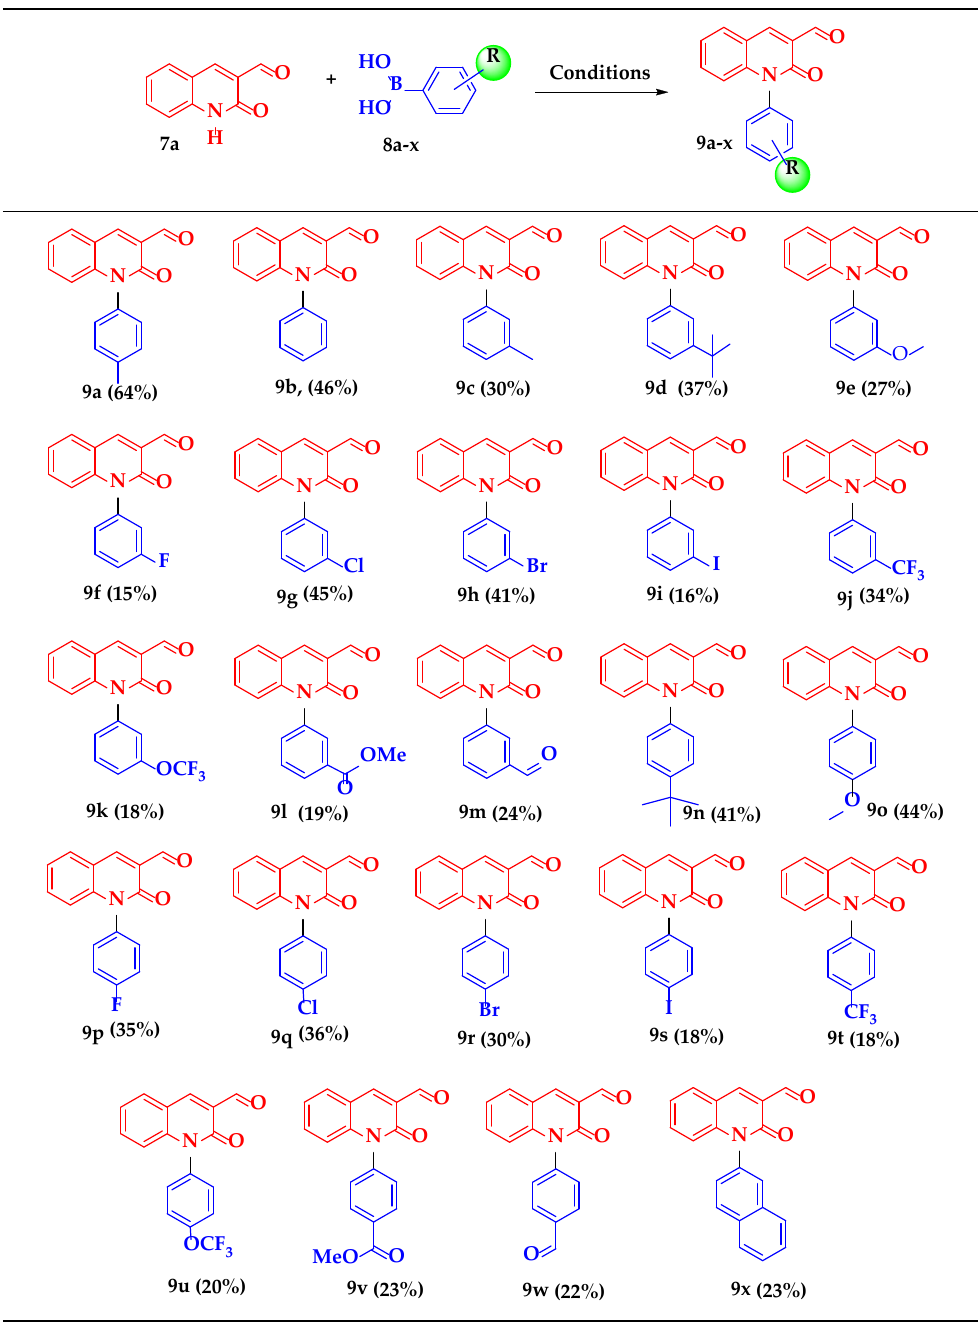
Table 2. Scope of the N -arylation of 3-formylquinolone a .